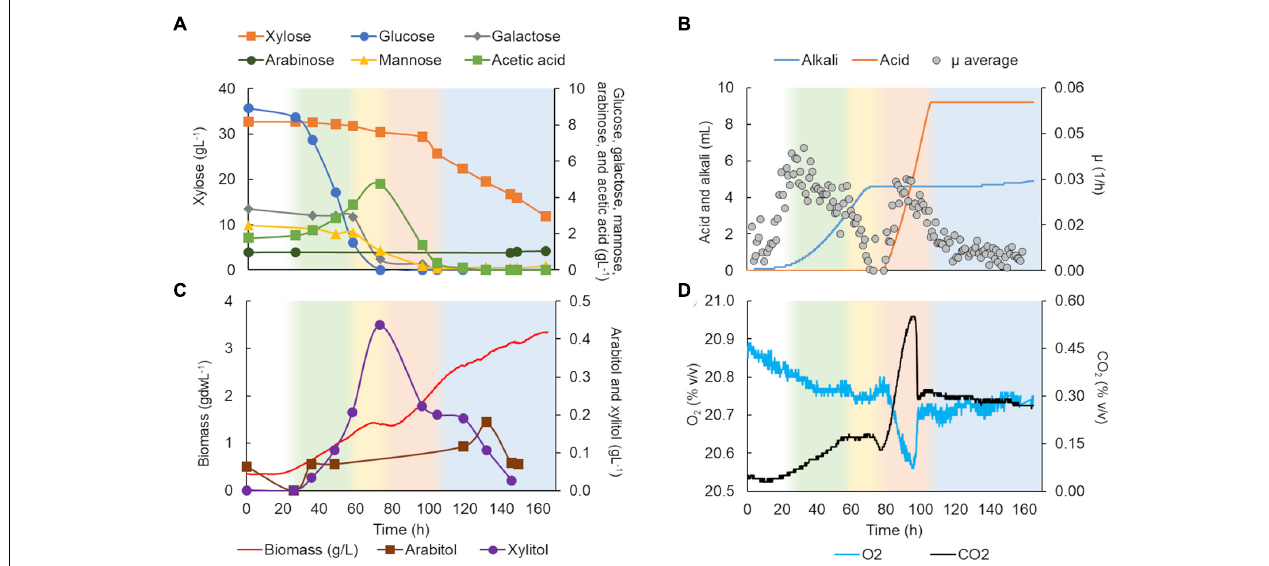
FIGURE 3 | Kluyveromyces marxianus CBS 6556 characterization in a bioreactor in C5-Birch hydrolysate diluted to 50 gL − 1 of total sugars. (A) Xylose, glucose, galactose, mannose, arabinose, and acetic acid consumption profiles (gL − 1 ); (B) added alkali and acid profiles to maintain the constant pH and average specific growth rate ( µ , h − 1 ); (C) xylitol and arabitol production and consumption profiles (gL − 1 ) and growth profile in biomass (gdwL − 1 ); and (D) CO 2 production and O 2 consumption profiles. The lag phase is depicted in white; the first, second, third, and fourth growth phases are shown in green, yellow, light orange, and light blue, respectively. Supplementary Table 3 contains all data and errors expressed in standard